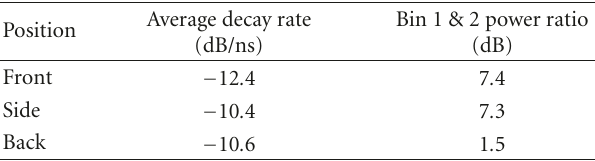
Table 1: Position-dependent power delay profiles for BAN